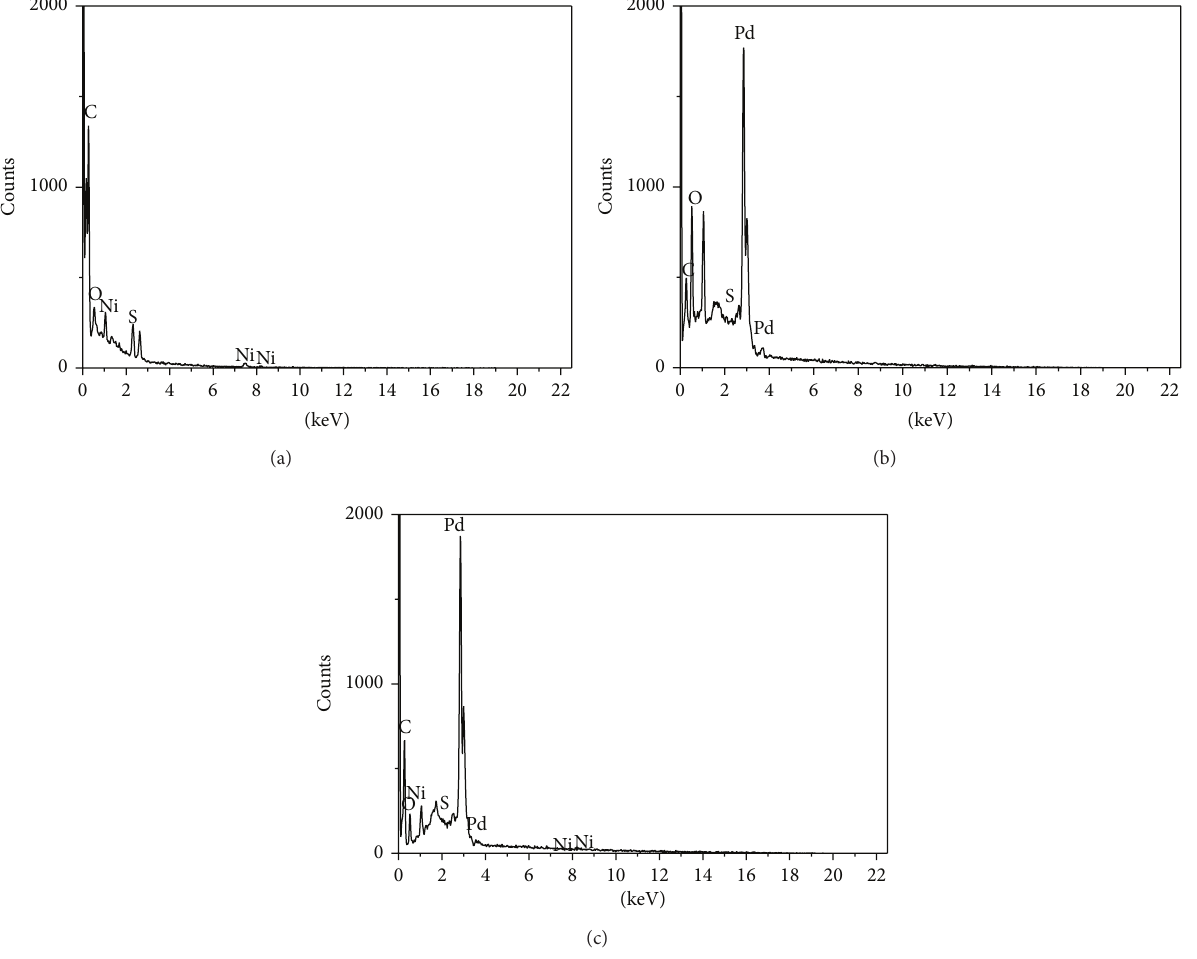
Figure 3: EDX spectra of (a) C-PANI-Ni, (b) C-PANI-Pd, and (c) C-PANI-Pd-Ni catalysts.